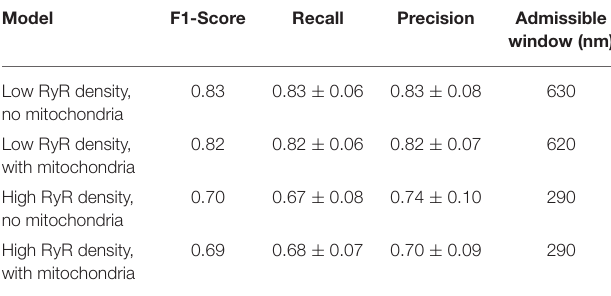
TABLE 1 | Ca 2+ release site detection performance results at maximum f1-score in each